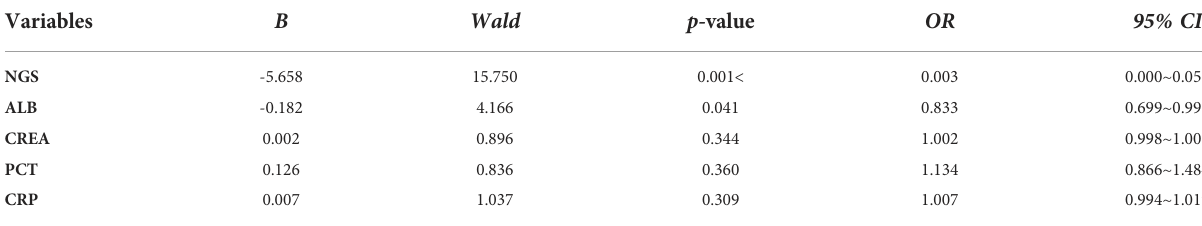
TABLE 2 Logistic regression analysis of